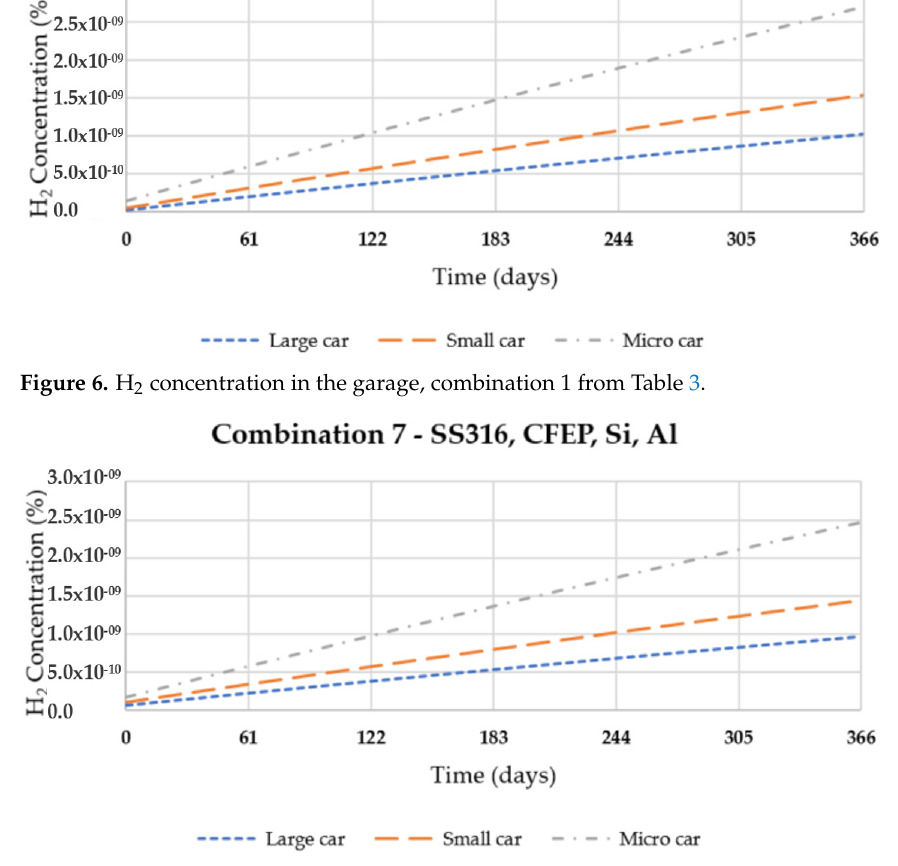
Figure 7. H 2 concentration in the garage, combination 7 from Table 3.